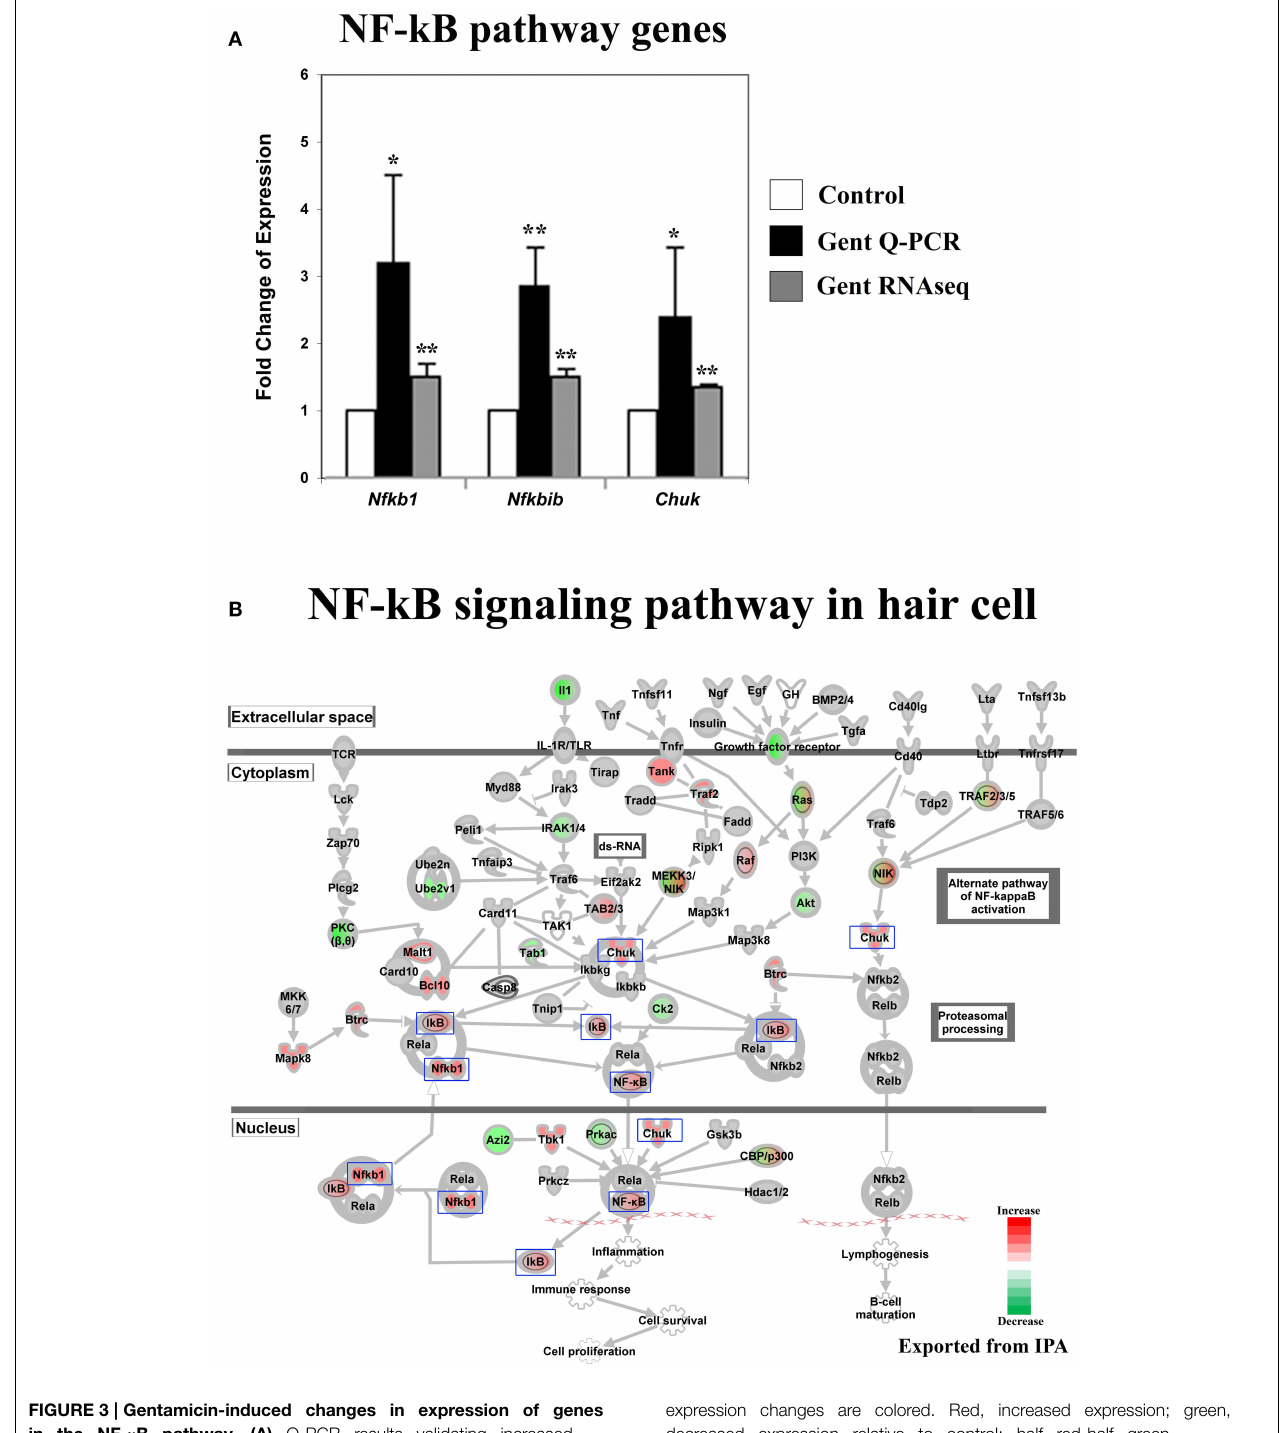
FIGURE 3 | Gentamicin-induced changes in expression of genes in the NF- κ B pathway. (A) Q-PCR results validating increased messenger RNA levels in hair cells after gentamicin treatment. Error bar, standard deviation: * p < 0 . 05 ; ** p < 0 . 01 . (B) NF- κ B pathway with color-coded expression changes suggesting early transcriptional response to gentamicin. Only genes with significant